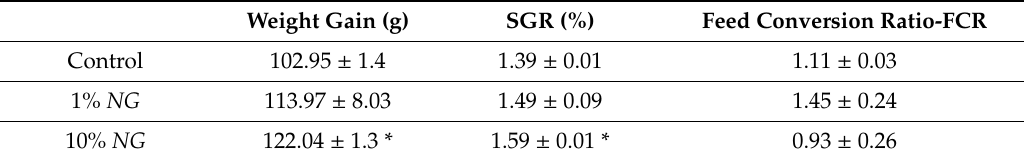
Table 5. E ff ect of NG concentrate inclusion level on weight-gain, Specific growth rate-SGR and Feed conversion ratio-FCR animals feed experimental diets.